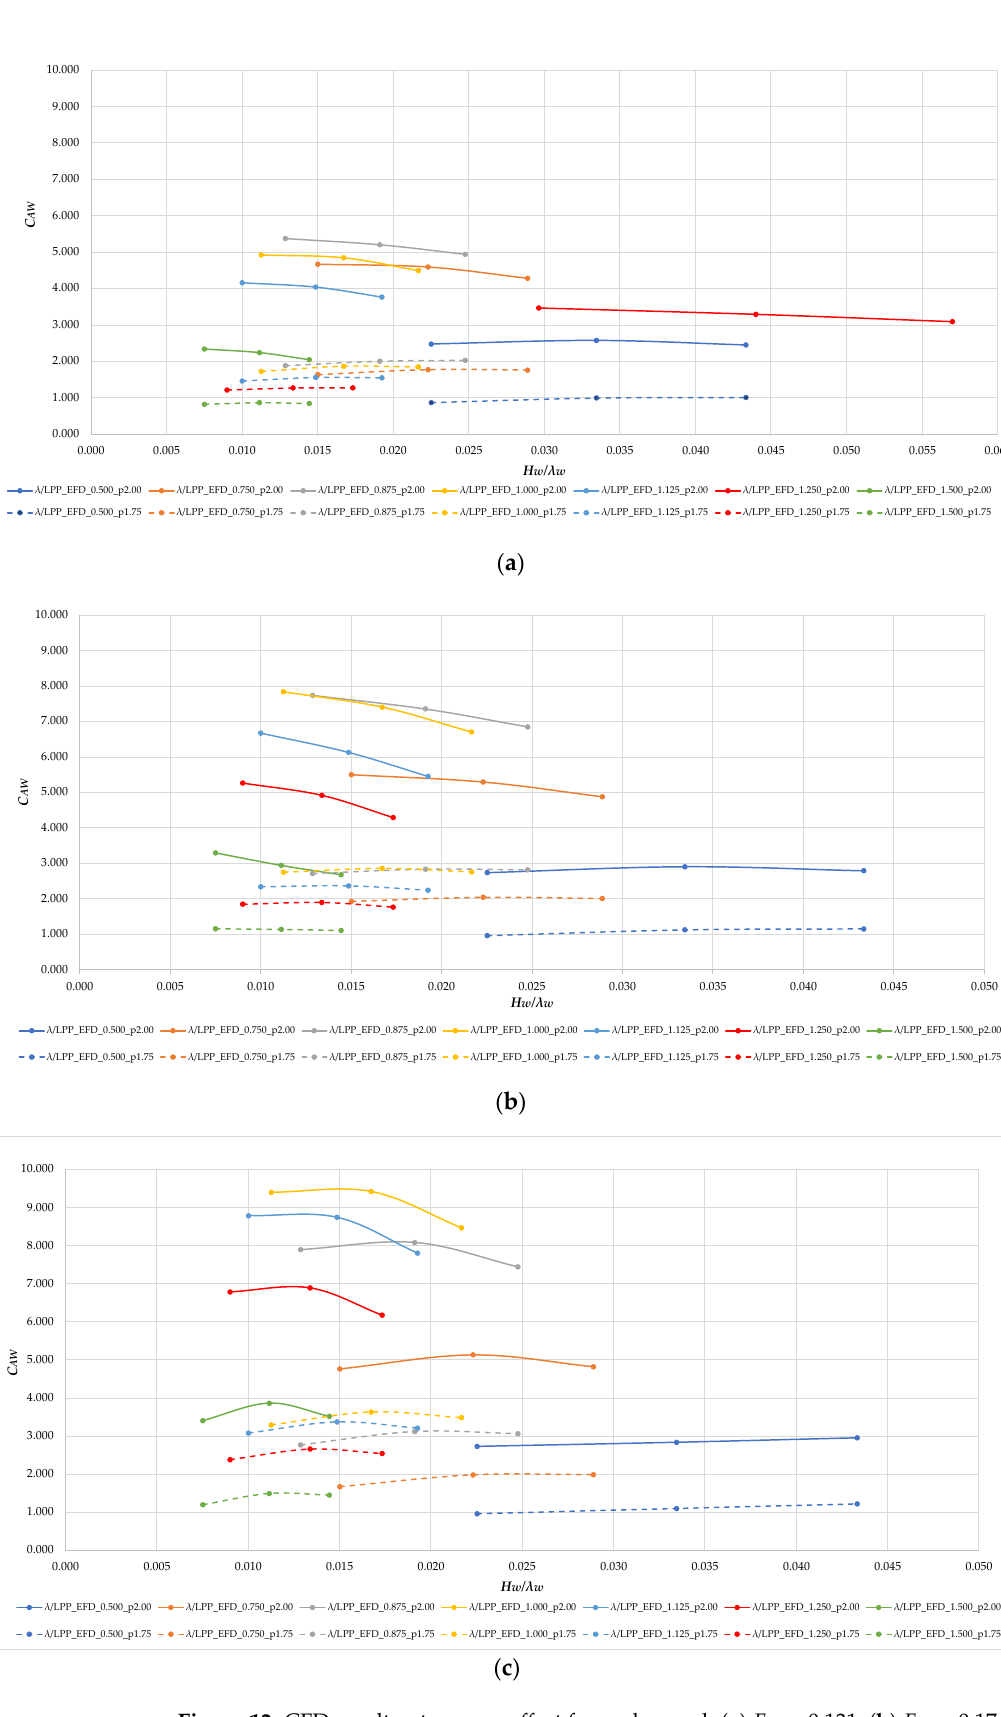
Figure 12. CFD results, steepness effect for each speed: ( a ) F R = 0.131; ( b ) F R = 0.174; ( c ) F R = 0.218.